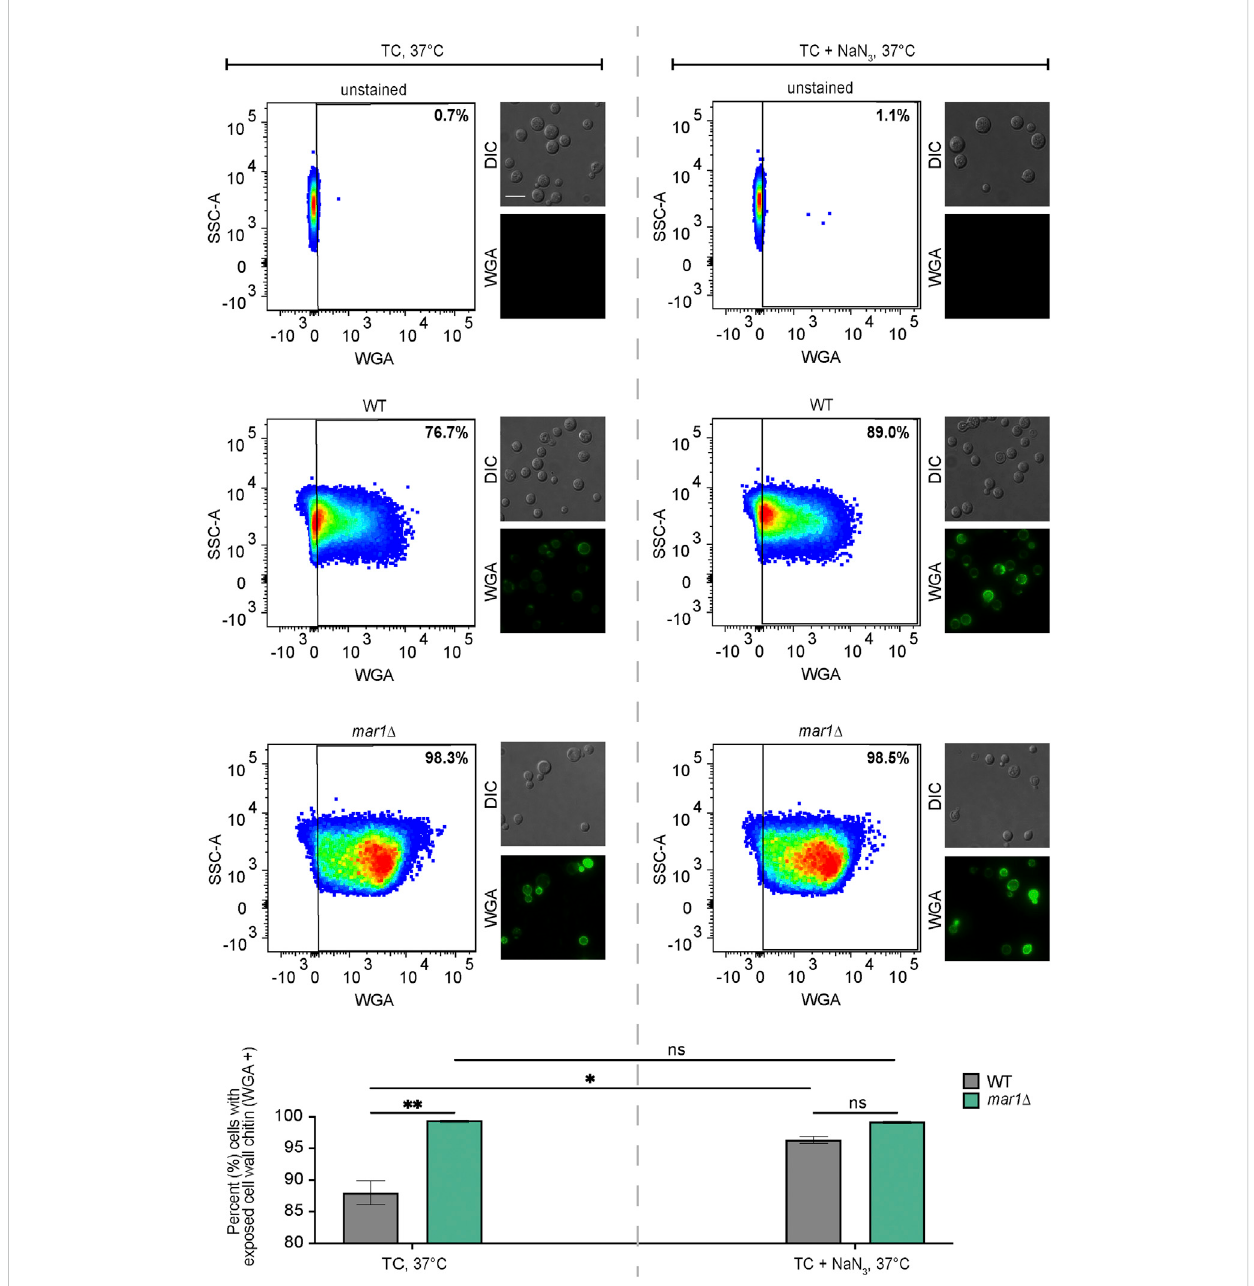
FIGURE 5 Cell wall changes induced by electron transport chain inhibition. Exposed cell wall chitin of the WT strain and the mar1 Δ mutant strain were measured following incubation in TC medium at 37 ° C in the absence (left) and presence (right) of sodium azide (NaN 3 ) (0.5 mM) for 24 h. Cells were stainedwithwheatgermagglutinin(WGA)asamarkerforexposedcellwallchitin.Flowcytometrywasusedtoquantifystainingintensity.Relevantevents were gated for live cells (FSC vs. SSC), single cells (FSC-H vs. FSC-A), and positive labelling (SSC vs. WGA, determined using unstained cells as negative controls). Data are represented as dot plots with mean fl uorescence intensity on the x-axis and SSC-A on the y-axis, with percentages of cells displaying WGA staining included. Identical samples werealso imaged byepi fl uorescence microscopy (63x scale bar, 10 μ m). The average percentage of cellsdisplayingWGAstainingacrosstwobiologicalreplicates( n =2)isalsoincluded.ErrorbarsrepresenttheSEM.Statisticalsigni fi cancewasdetermined using two-way ANOVA and the Tukey-Kramer test (*, p < 0.05; **, p < 0.01; ns, not signi fi cant). DIC, differential interference